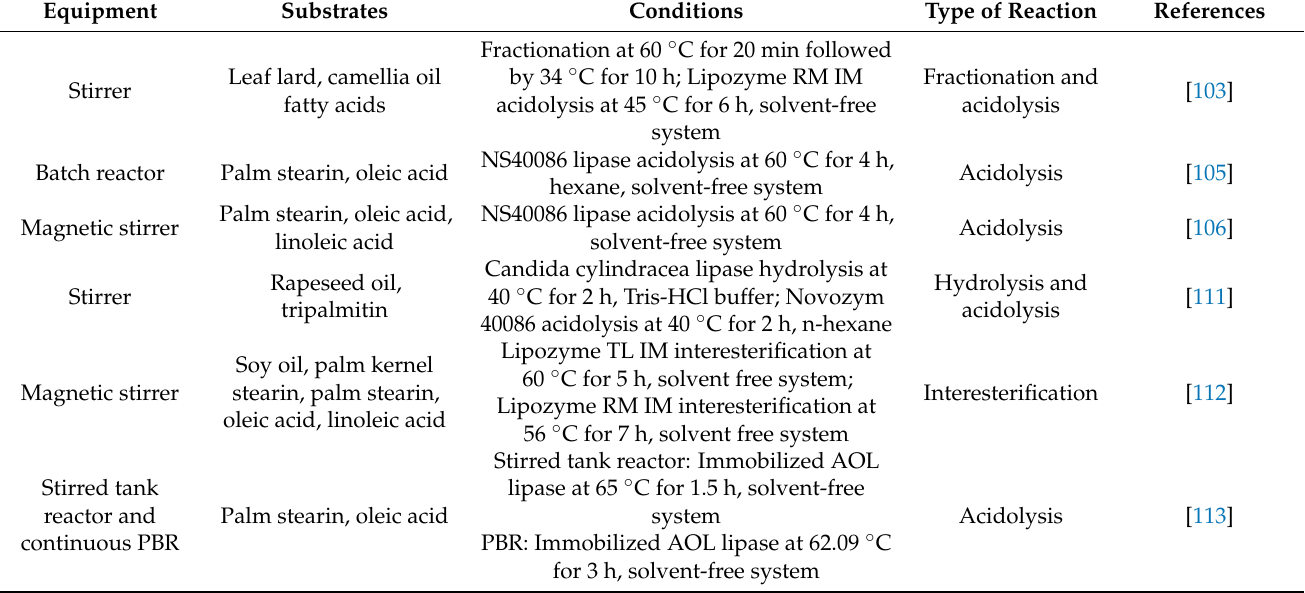
Table 6. Current enzymatic synthesis methods to produce human milk fat substitute